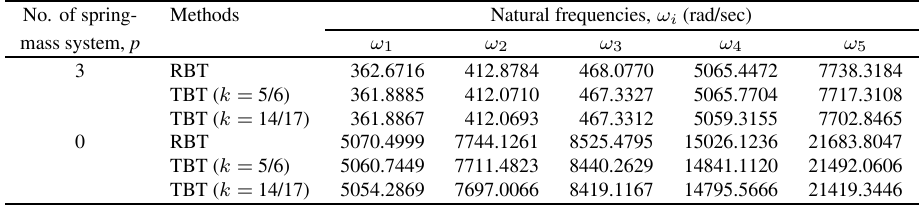
Table 4 The fi rst fi ve natural frequencies of the uniform three-span Reddy-Bickford and Timoshenko beams